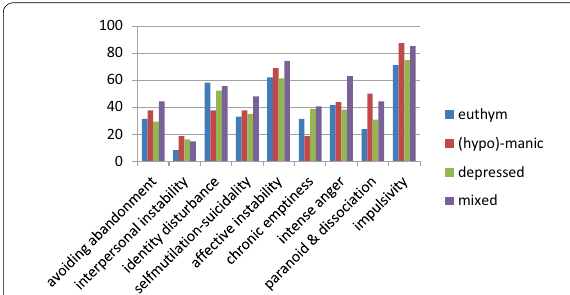
Fig. 1 Proportion self-rated BPF profile of patients in various mood states